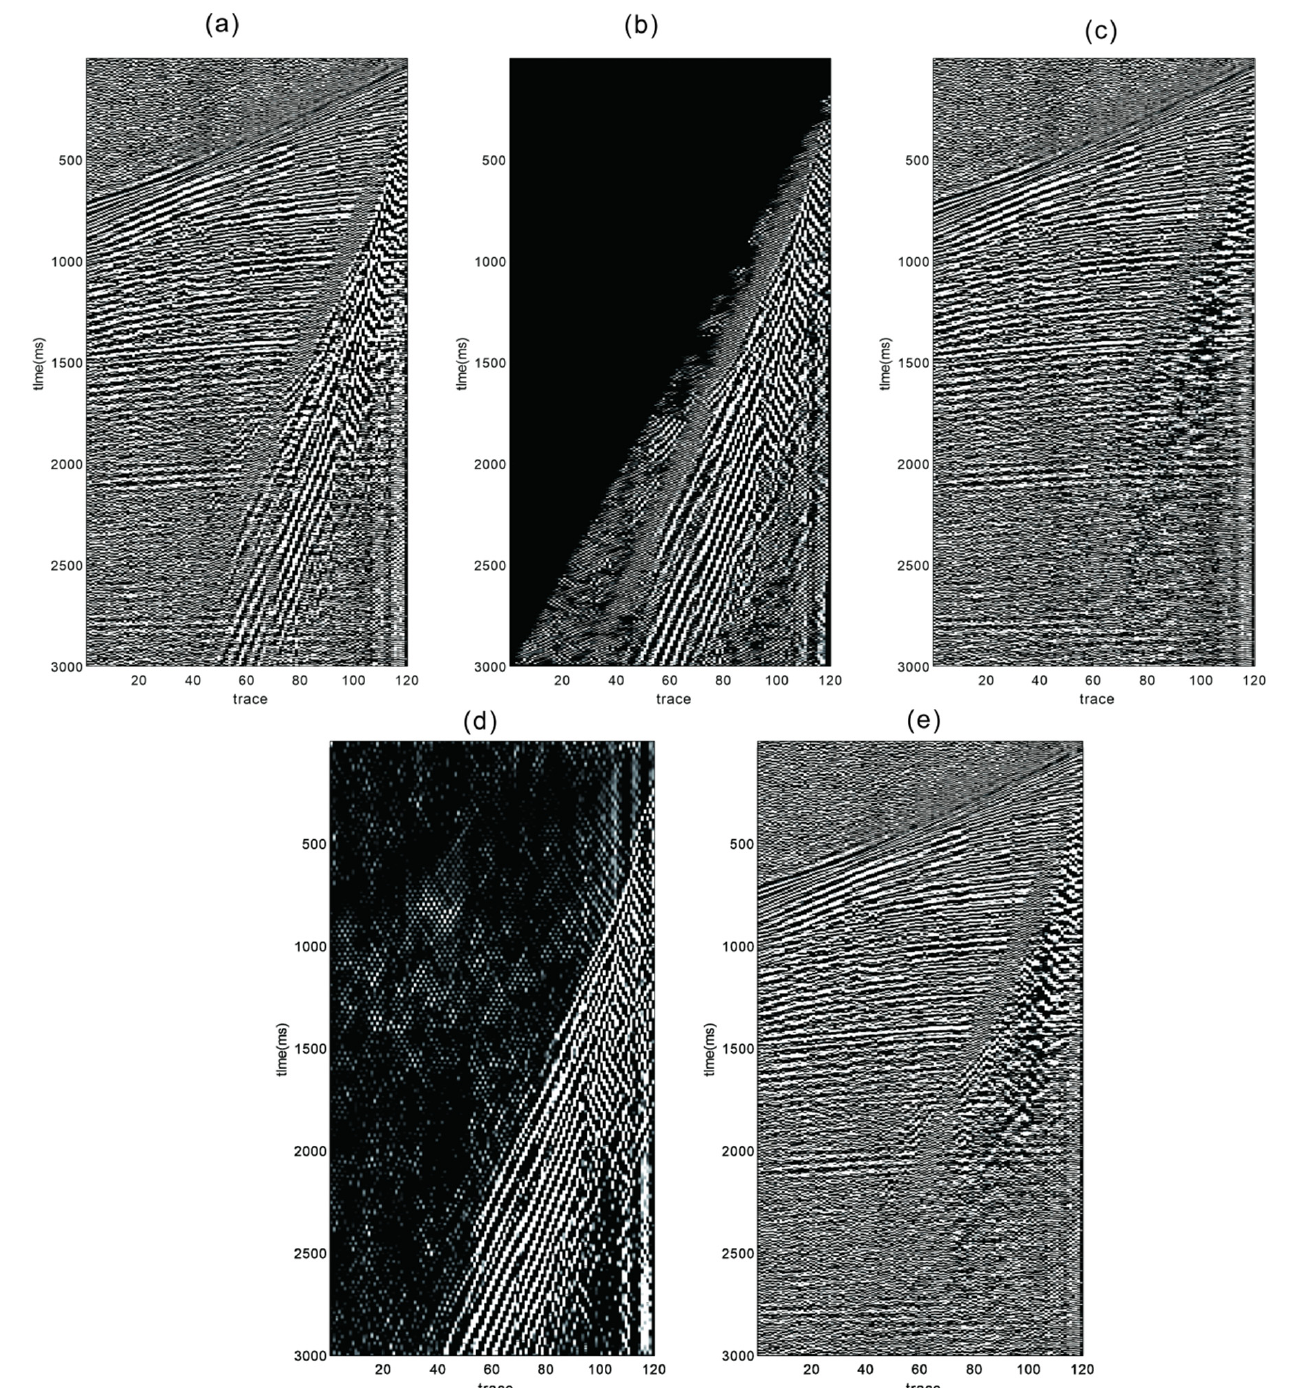
Figure 7. The processing results of the field seismic data using the proposed method. ( a ) The field seismic data. ( b ) The removed noise by NSST. ( c ) The seismic data after the NSST. ( d ) The removed noise by FK filter. ( e ) The seismic data after the FK filter.